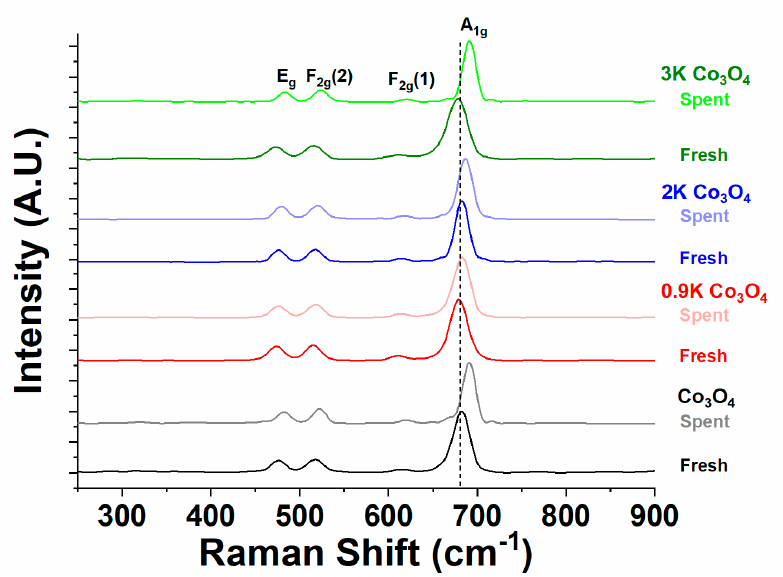
Figure 9. Raman spectra of fresh and spent Co 3 O 4 catalysts with varying K loading. The A 1g , E g , and two F 2g Raman bands of Co 3 O 4 are labelled for reference. The drop line is extended to emphasize the shift in the A 1g peak for fresh vs. spent catalysts.